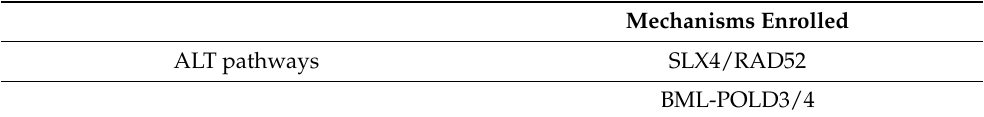
Table 1. Alternative Telomere Lengthening (ALT)